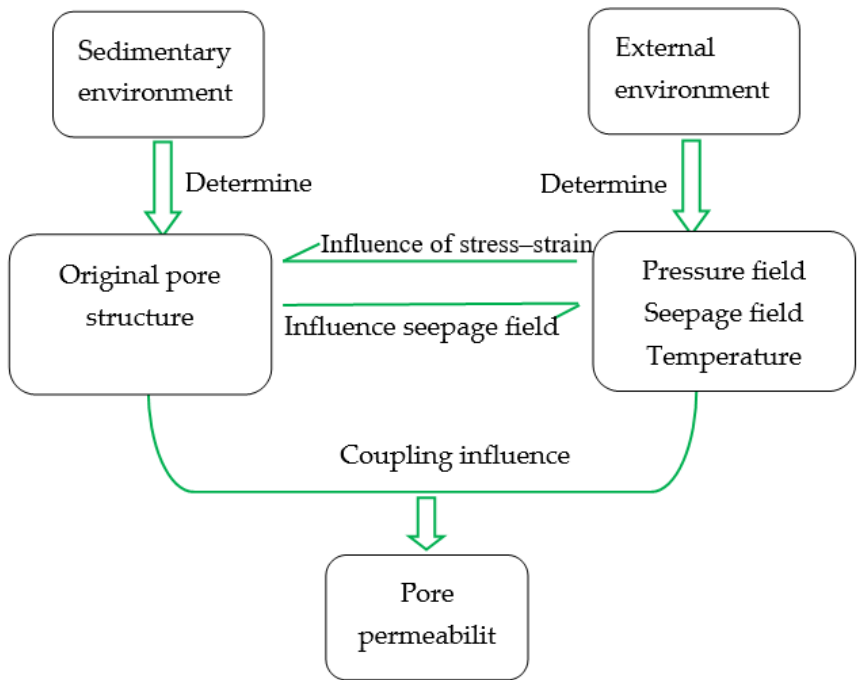
Figure 17. Relationship between pore permeability and various influencing